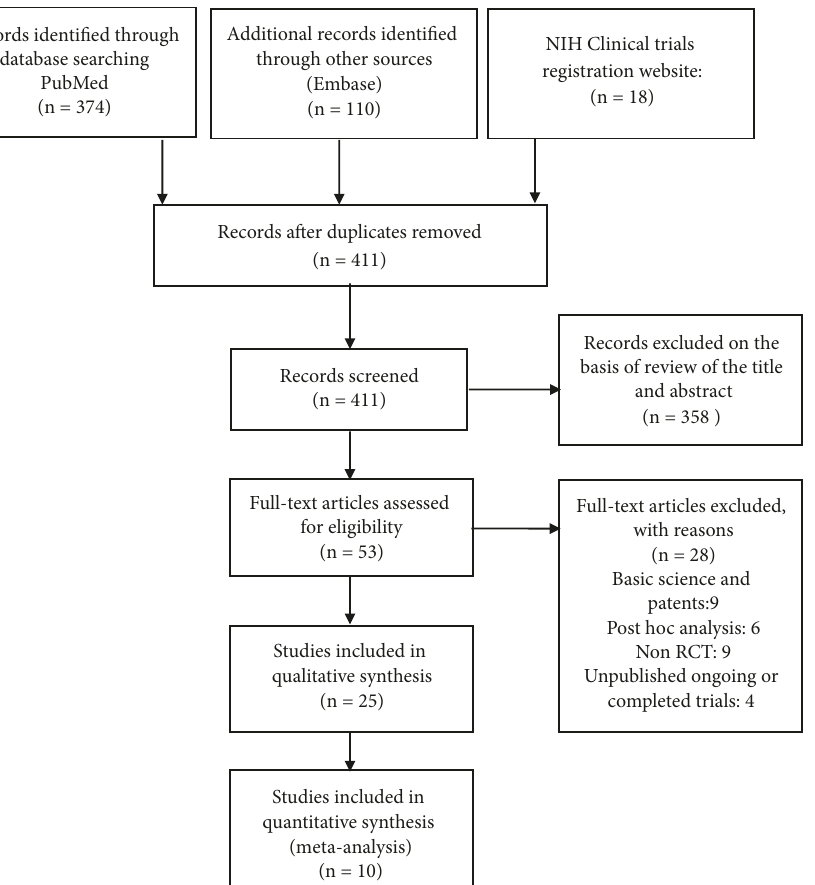
Figure 1: Flowchart of included studies . NIH: National Institutes of Health. RCT: randomized clinical trial.